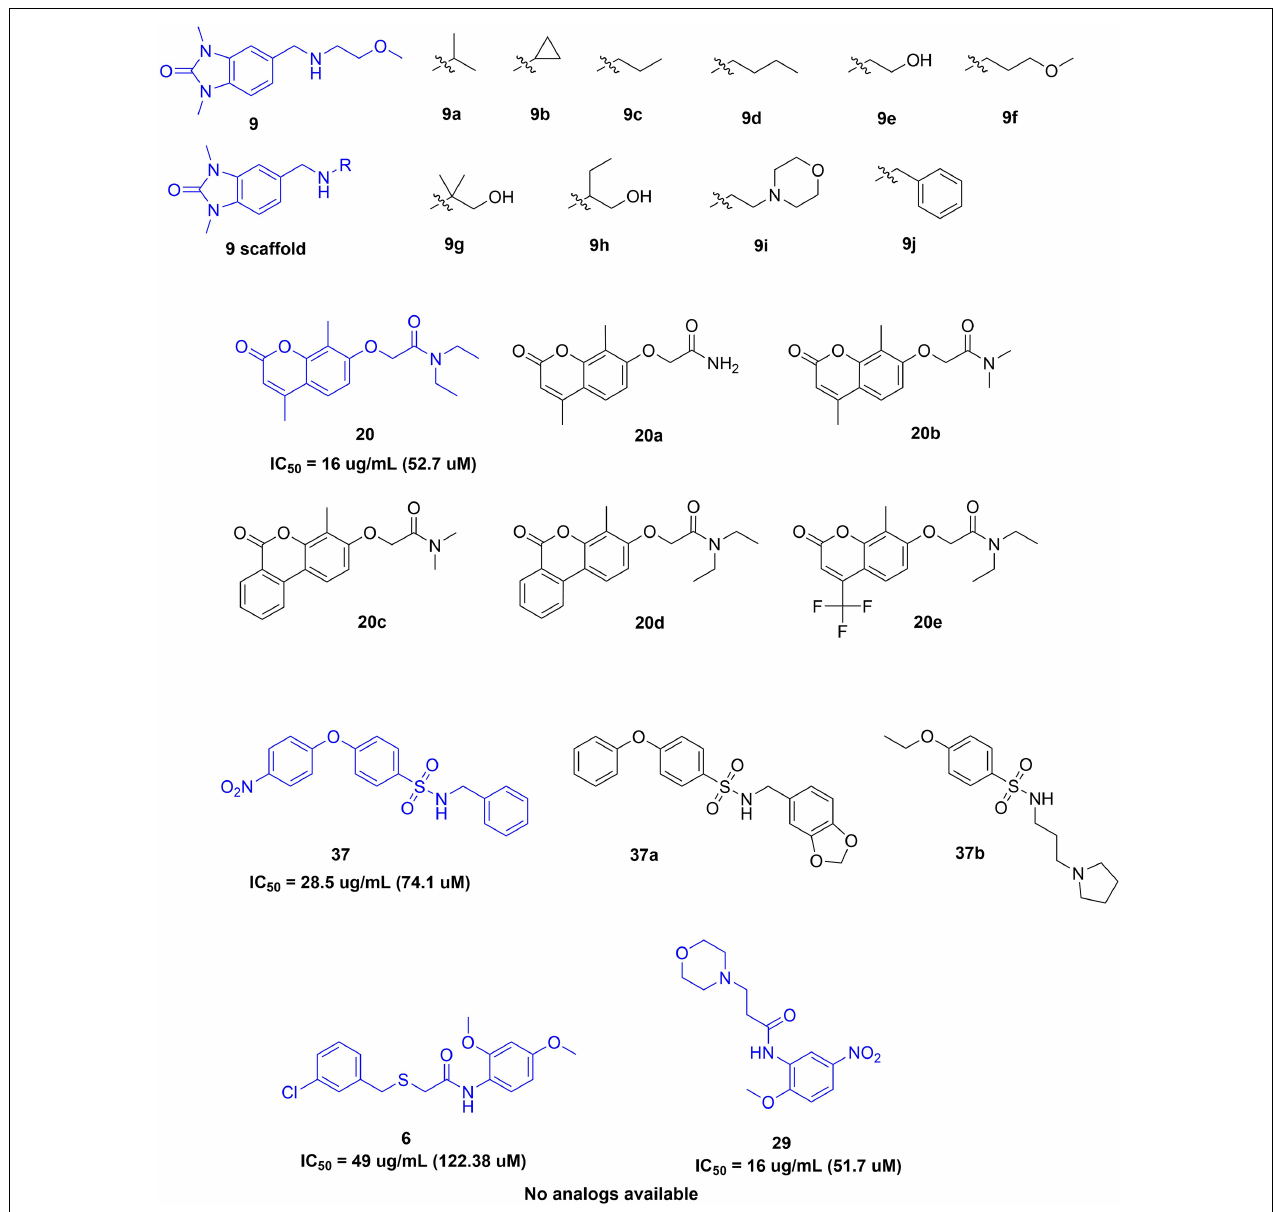
FIGURE 2 | Structures of analogs designed and selected for the second in vitro screen and for micro- and macrofouling evaluation.